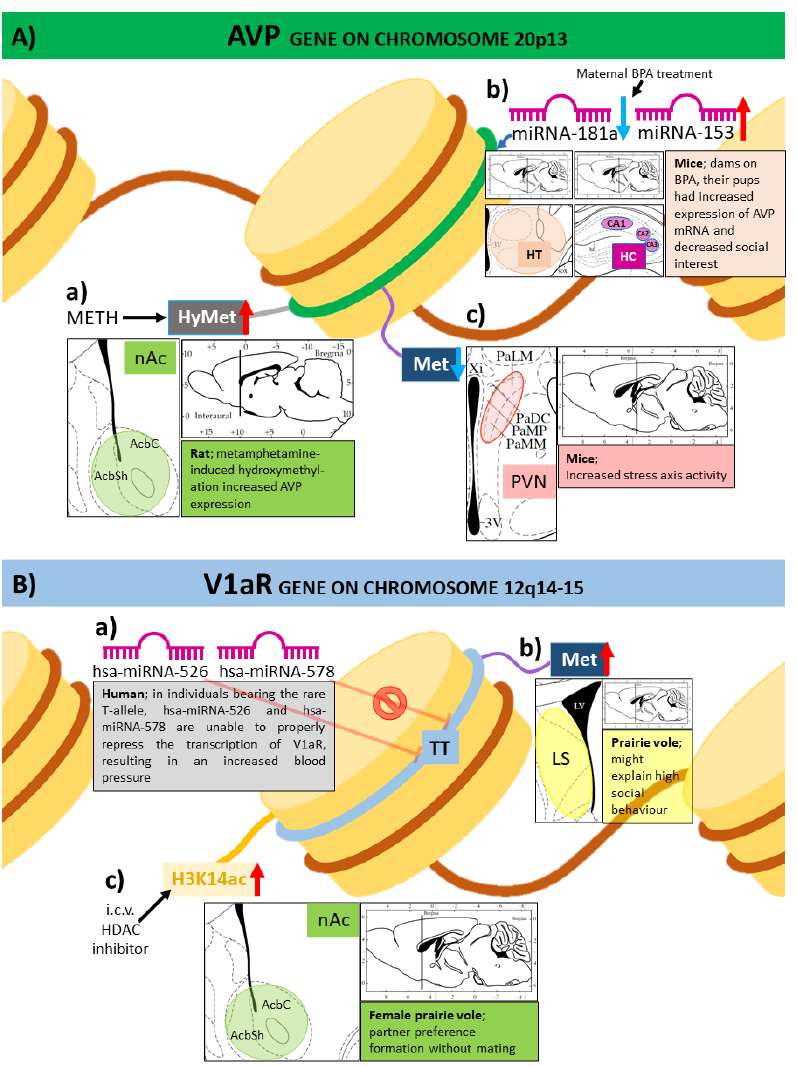
Figure 3. Increased vasopressin (AVP, A )- or AVP receptor ( B ) gene expression changes linked to epigenetic effects in the literature. ( A ) AVP gene ( a ) Methamphetamine-induced hydroxymethylation (HyMet) increased AVP gene expression in the nucleus accumbens (nAc). AcbC: nAc core region; AcbSh: nAc shell region. ( b ) California mouse dams on diet (before, during and after pregnancy) containing bisphenol A (BPA, commonly found in plastics) gave birth to pups that had increased expression of AVP mRNA in the hypothalamus (HT) and hippocampus (HC), with increased microRNA-153 (miRNA-153) and decreased miRNA-181a levels; CA1-2-3: cornu ammonis 1-2-3 of HC. ( c ) Decreased methylation (Met) was found in mouse nucleus paraventricularis (PVN), which was accompanied by increased AVP gene expression, resulting in stress axis hyperactivity. ( B ) AVP receptor type 1a (V1aR) gene. ( a ) A study about human genome-wide single-nucleotide polymorphisms found an association between the polymorphism of miRNA binding site of the V1aR gene and blood pressure. Two variants were identified: a common G-allele (see in Figure 4). ( B ) and a rare T-allele. In vitro, Homo sapiens (hsa)-miRNA-526 and hsa-miRNA-578 normally reduce V1aR gene expression. However, in the case of T-allele, this repression was either decreased (hsa-miRNA-526) or even completely abolished (hsa-miRNA-578). Individuals bearing homozygous T-allele thus had increased expression of V1aR and higher blood pressure (both systolic and diastolic) compared with homozygous G-allele bearers. TT: thymine-thymine allele variant in V1a receptor gene. ( b ) Hypermethylation on V1aR gene in lateral septum (LS) might contribute to the high social behavior of prairie voles. ( c ) Acetylation increase in Histone 3 Lysine 14 (H3K14ac) by histone deacetylase (HDAC) inhibitors lead to partner preference formation without mating in the nAc of female prairie